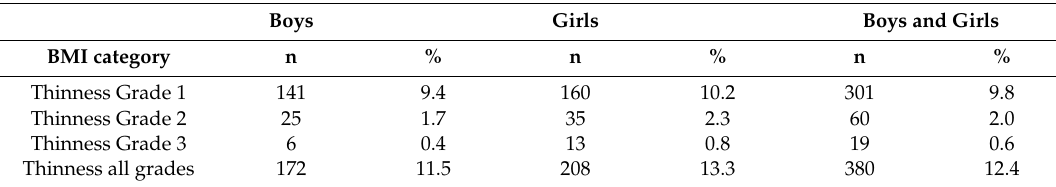
Table 2. The category of thinness in rural boys and girls. Boys Girls Boys and Girls